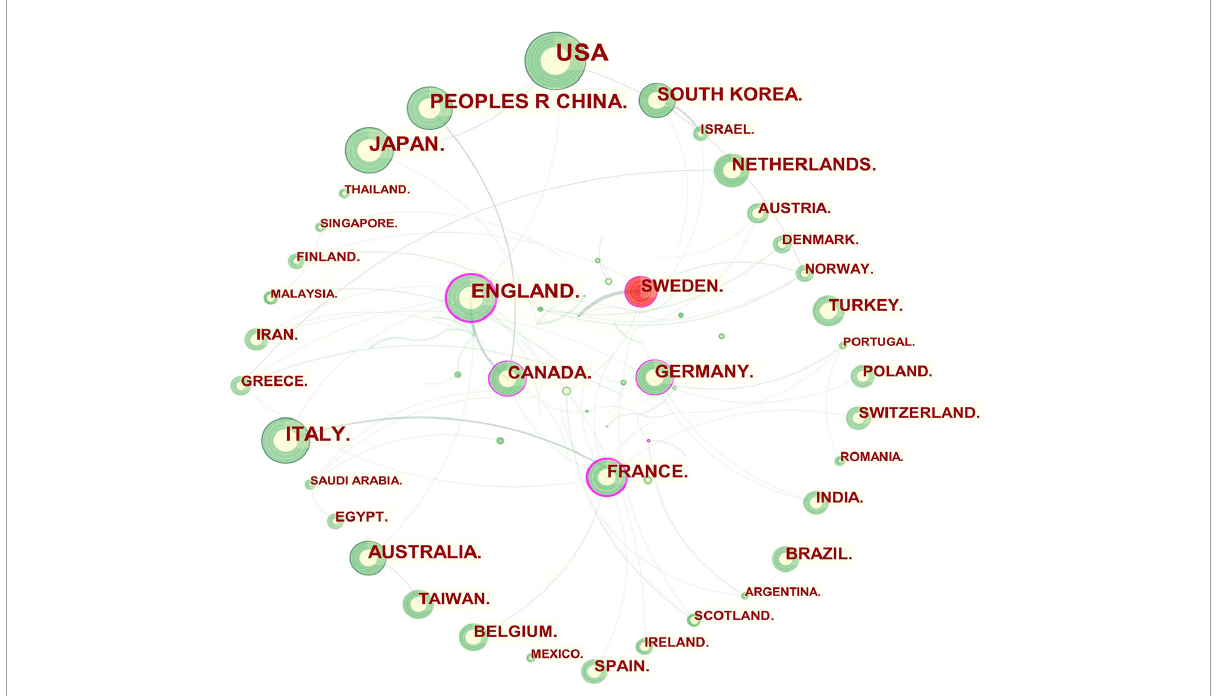
FIGURE2 Network of countries and regions engaged in GERD research. In the network map, a node represents a country or region. The larger the area of the node is, the larger the number of publications. The thicker the curved line connecting nodes indicates the frequency with which they co-occur, as they indicate collaborative relationships. An isolated node without any connection is devoid of all collaboration. A node with a high betweenness centrality links two or more large groups of nodes. A node with a high betweenness centrality score exerts a strong influence on the network. A purple trim indicates a high degree of betweenness centrality. Red tree rings indicate bursts of citation. The greater the thickness of the red tree rings, the greater the bursts for the corresponding